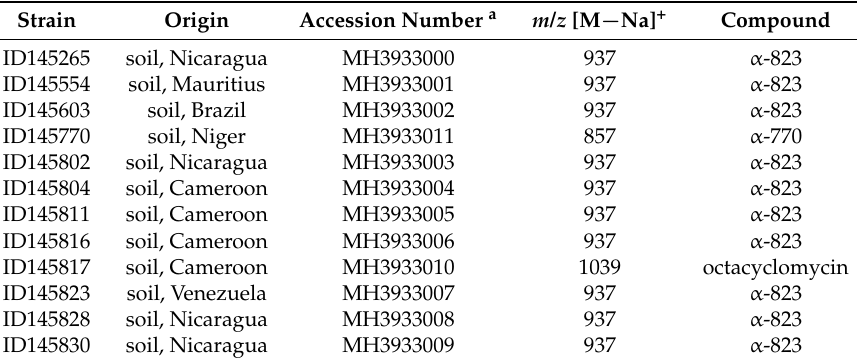
Table 2. Polyether-producing Actinoallomurus